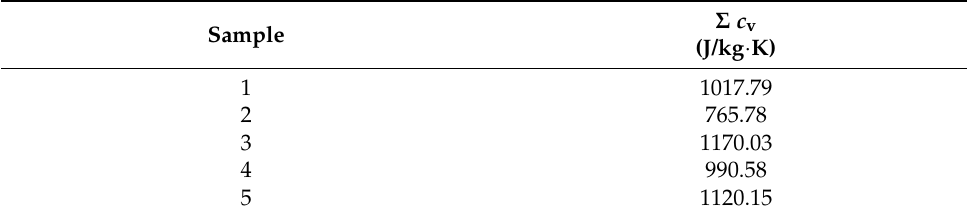
Table 5. The total specific heat of the tested